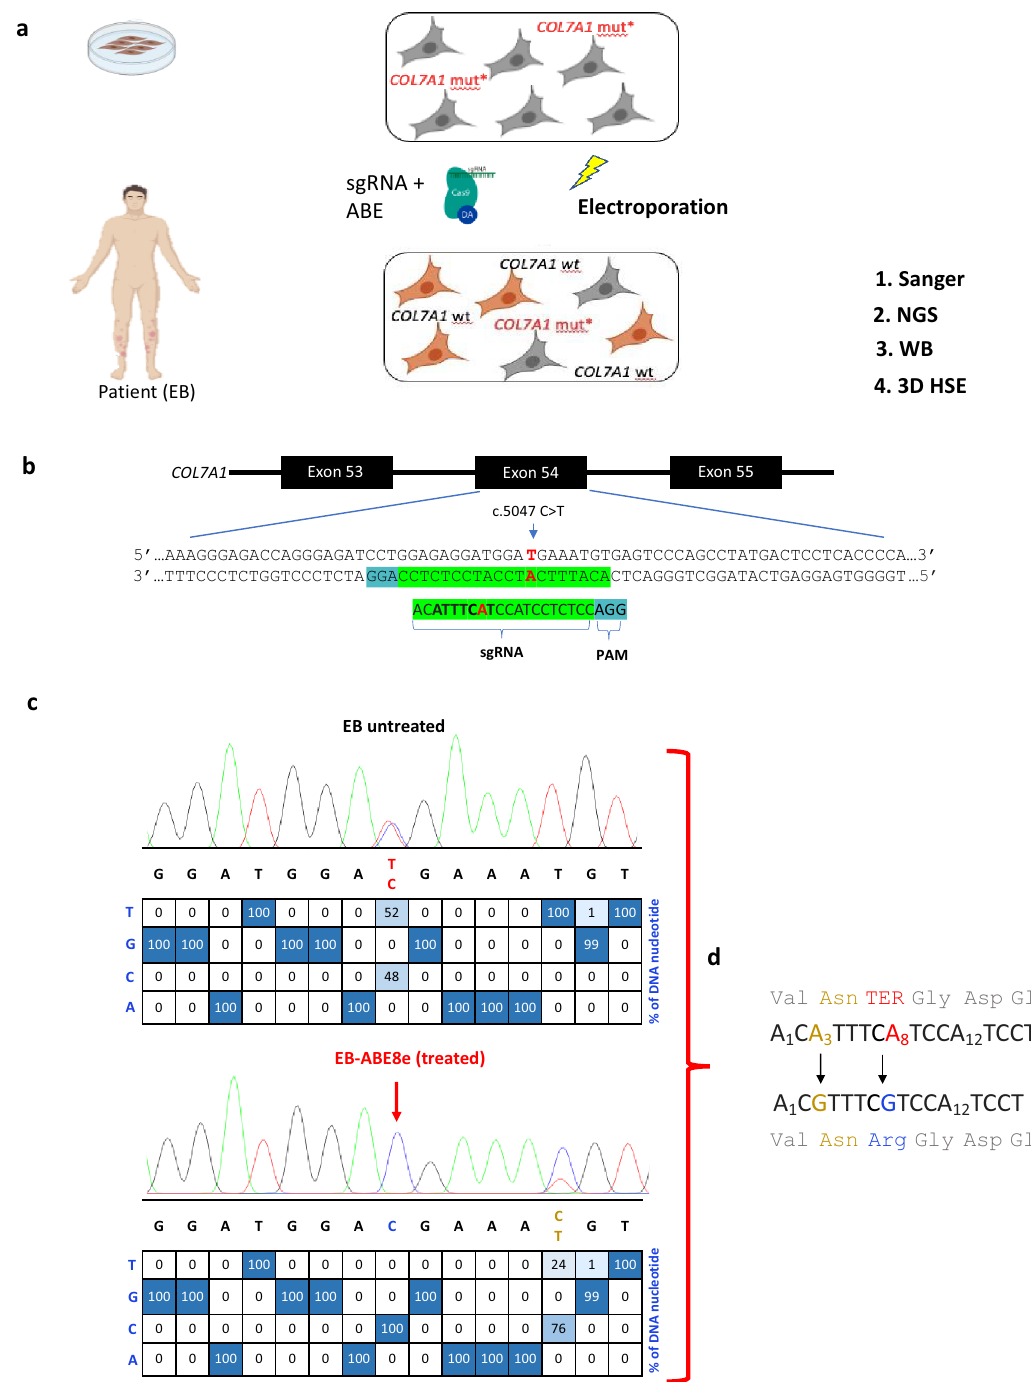
Figure 2. Design of base editing experiments and initial outcomes. ( a ) Strategy to correct a bulk population of patient-derived fibroblasts by electroporating ABE with a single guide (sg)RNA. Post-editing analysis used Sanger sequencing and Next generation sequencing (NGS) on both the DNA and RNA levels. Studies on C7 protein involved Western blotting (WB) and 3-Dimensional human skin equivalents (3D HSE) generated from fibroblasts and keratinocytes. ( b ) The chemically modified sgRNA used for all base editing experiments was designed with the mutated nucleotide in position 8 (shown in red) of its 20-base protospacer, on the complementary strand. The editing window (positions 3–9) is in bold and the required ‘NGG’ protospacer adjacent motif (PAM) site is highlighted in blue. ( c ) In-silico analysis of Sanger sequencing data suggested all alleles containing the mutation (shown in red) were corrected. Sequencing also uncovered a bystander mutation had been introduced in 76% of alleles ( d ) Correction of the nonsense mutation in position 8 reversed the pathogenic amino acid change from a termination codon (red) to arginine (blue). The bystander mutation, introduced at position 3, conferred a silent asparagine-to-asparagine amino acid change (gold). No other nucleotides in the protospacer were